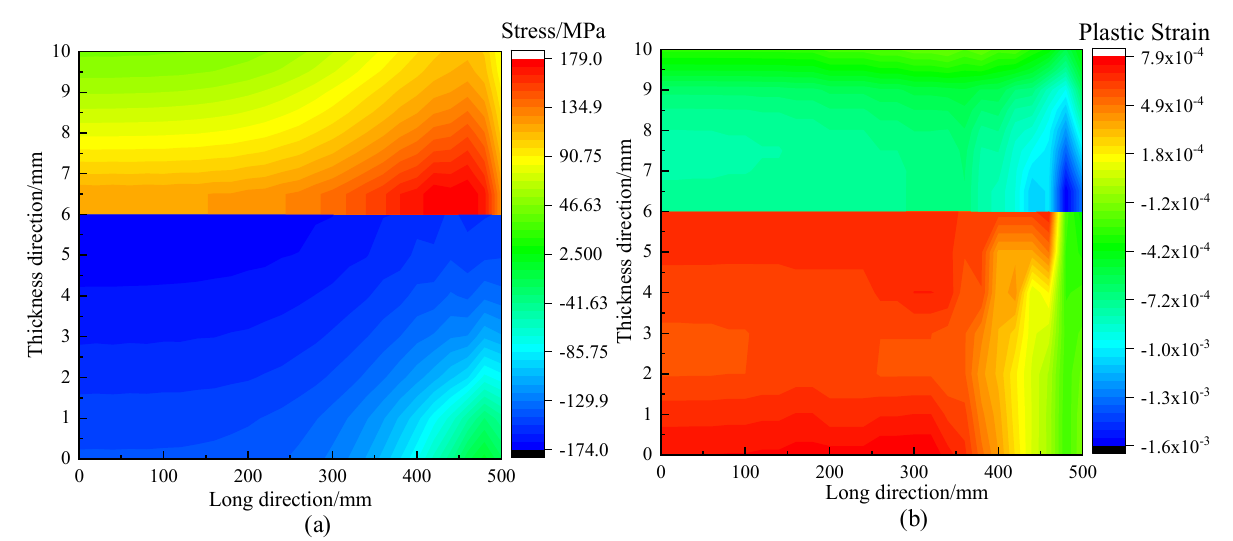
Figure 18. Distribution cloud diagram of longitudinal stress and plastic strain after rapid cooling